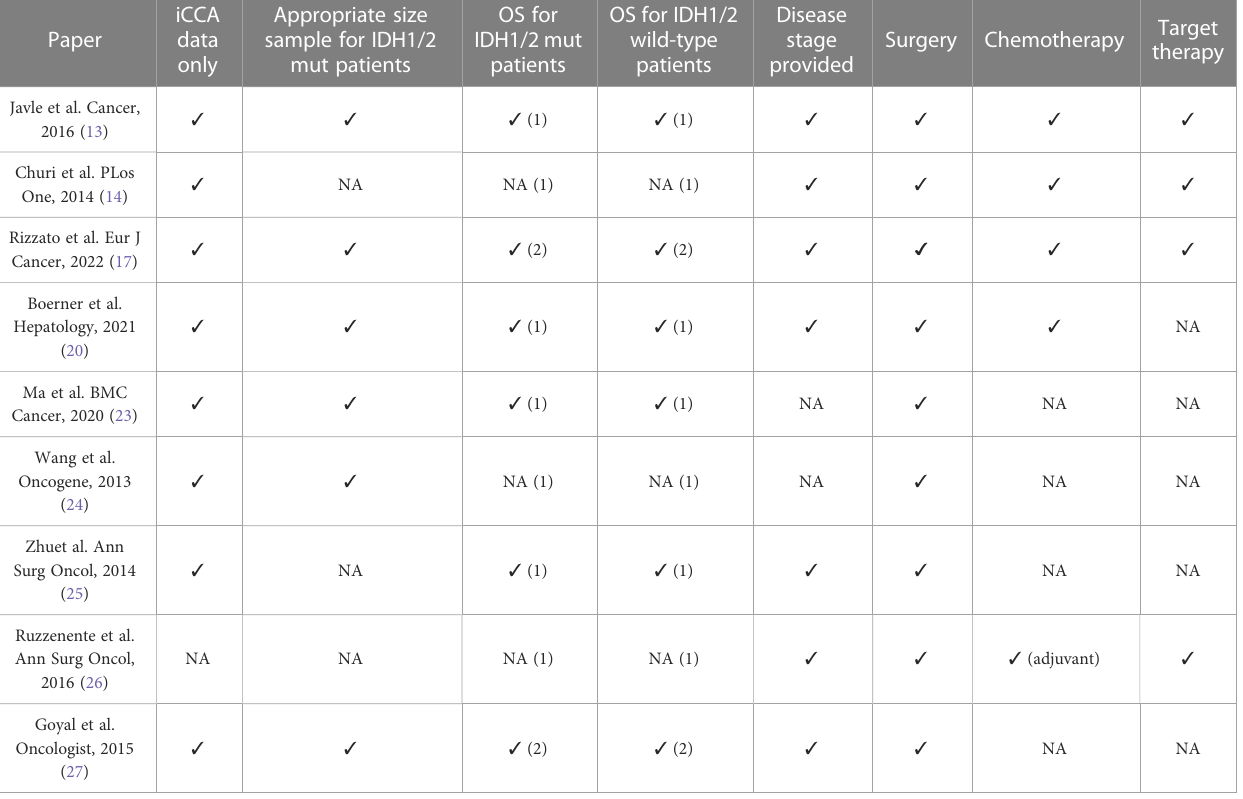
TABLE 4 Trial ’ s bias/shortcoming, if relevant data are provided, a checkmark sign is used ( ✓ ), otherwise a (NA) standing for Not Available is used.